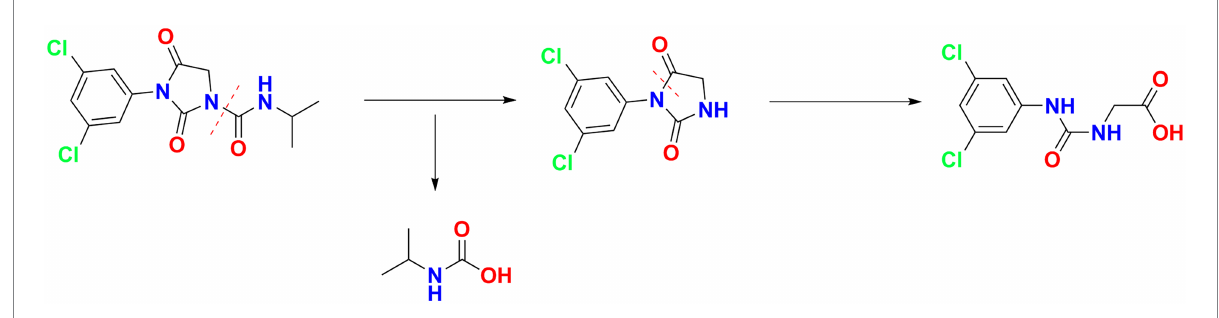
FIGURE 7 The metabolic pathway of iprodione by Azospirillum sp. A1-3.